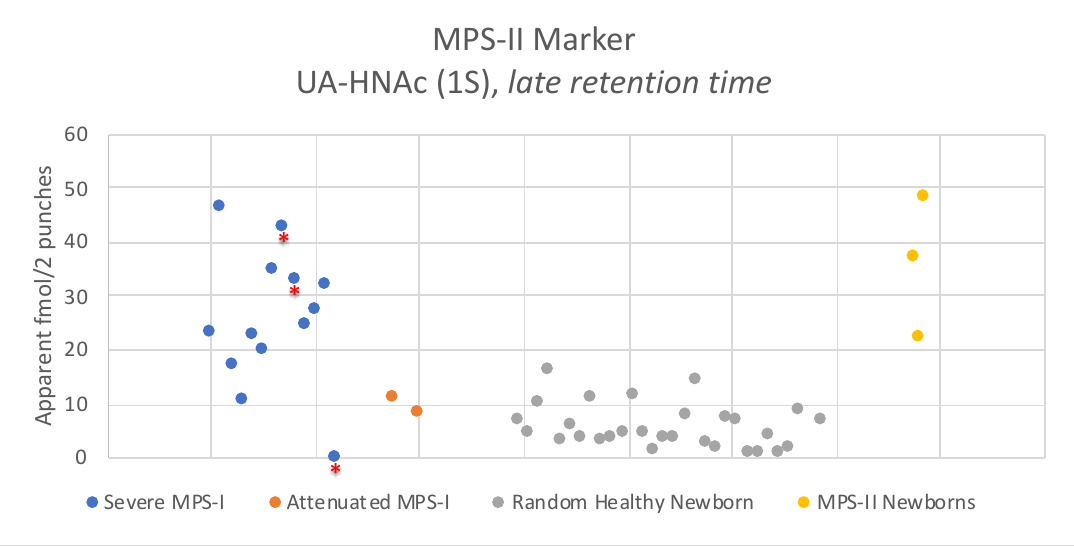
Figure 5. Levels of endogenous disaccharide biomarker UA-HNAc(1S) (late retention time) PMP derivative in newborn DBS from 30 random newborns (non-MPS-I), from 13 severe MPS-I patients, from two attenuated MPS-I patients, and from three MPS-II patients. Asterisked dots are from newborn DBS that were stored at ambient temperature, all others were stored frozen.